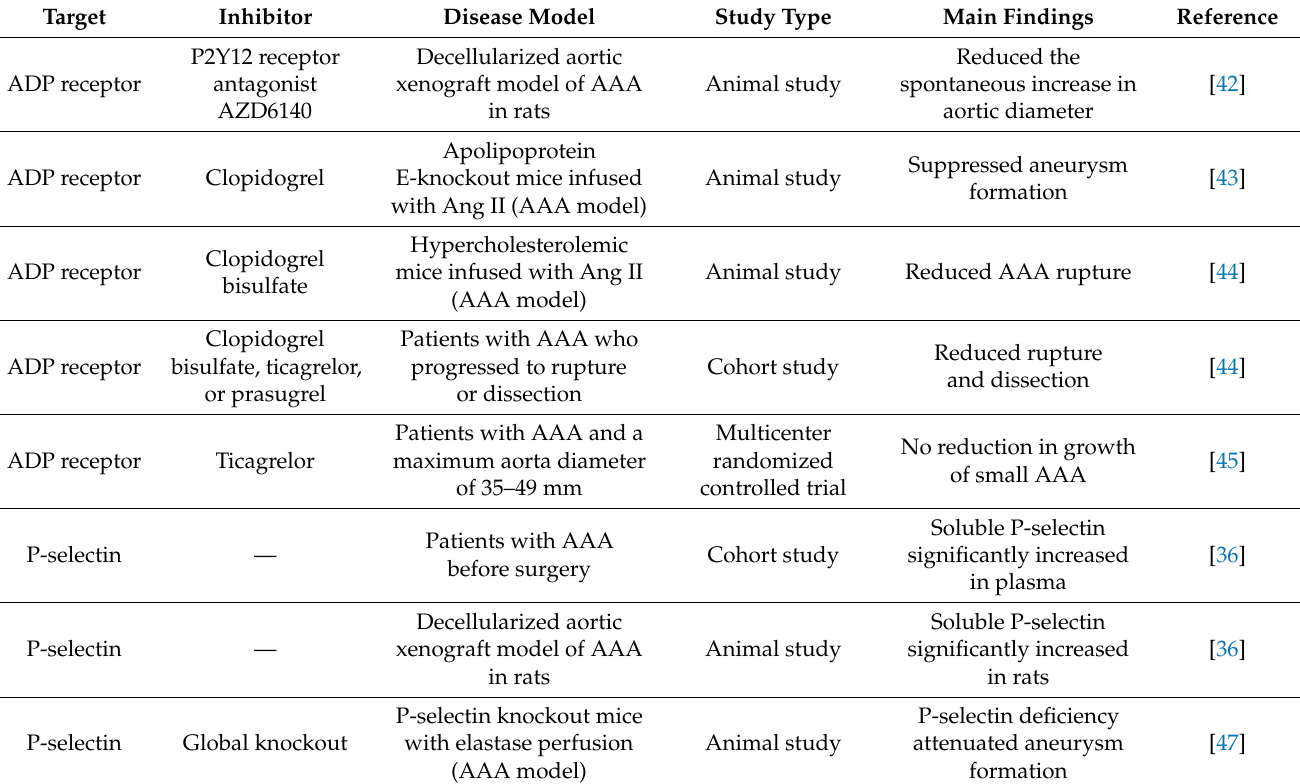
Table 1. Characteristics of studies of platelet receptors in